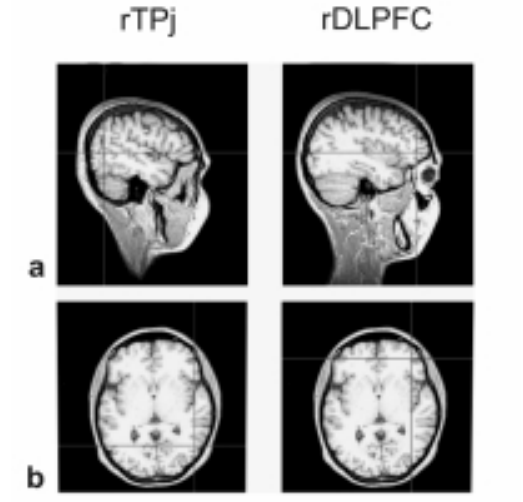
Fig. 1. Anatomical localization of rTMS sites over RMN of a rep- resentative subject. Sagittal ( a ) and axial ( b ) sections are reported for both right temporo-parietal junction (rTPJ; Tailarach coordinates: x = 48 y = − 55 z = 26 ) and right dorsolateral prefrontal cortex (rDLPFC; Tailarach coordinates: x = 38 y = 45 z = 26